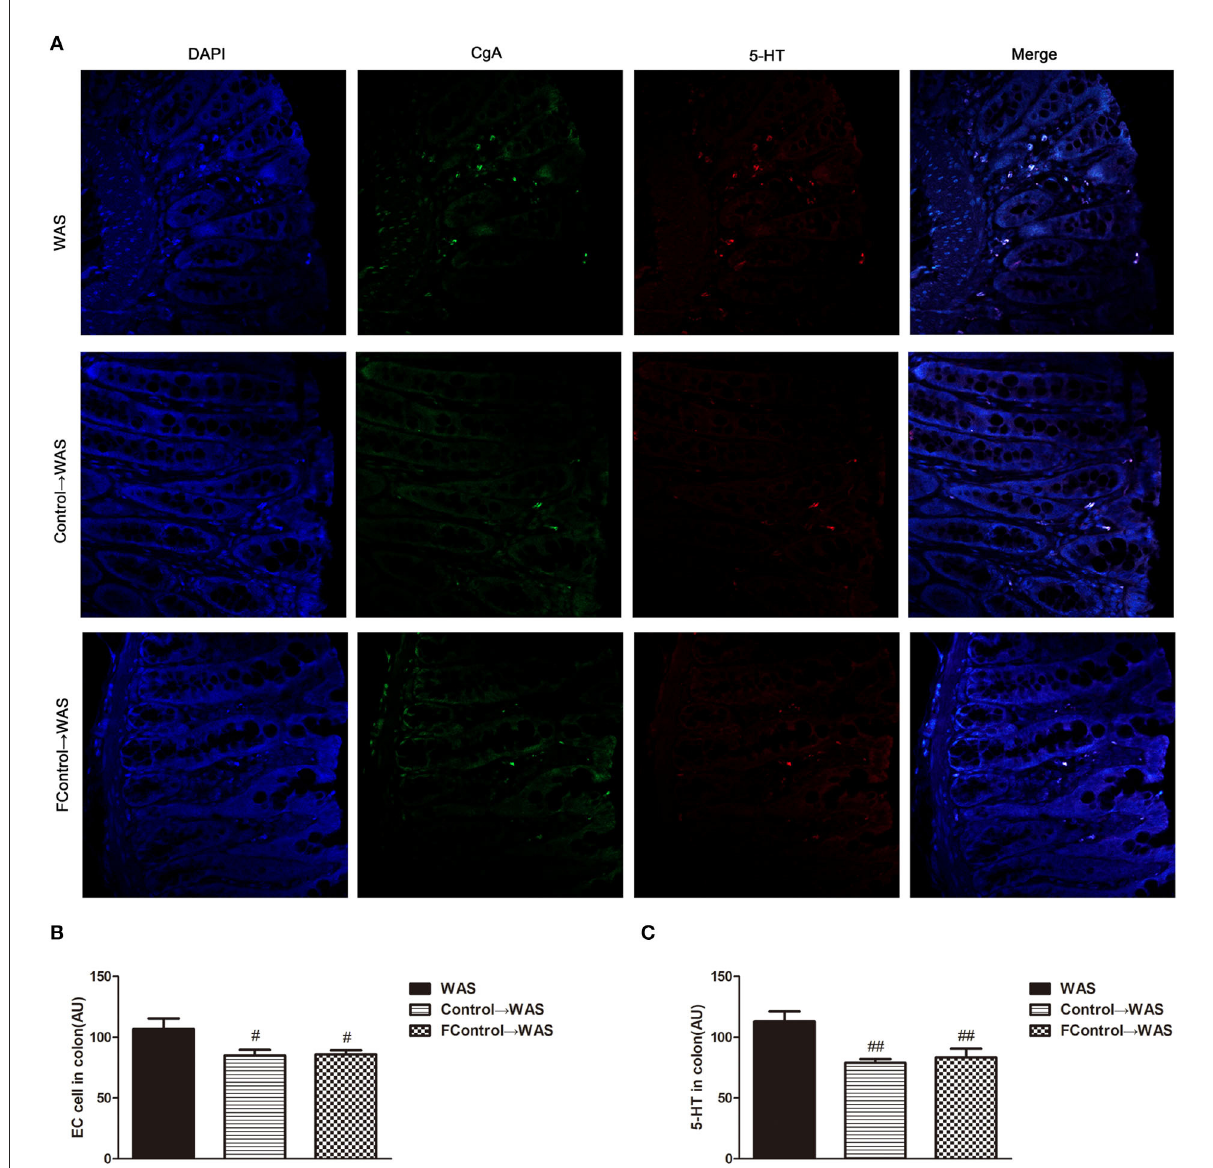
FIGURE7 Effect of filtered FML on ECs numbers and 5-HT Content in the Colon of Rats. (A) Colon immunofluorescence staining in rats. (B ) Statistical plot of ECs numbers in the colon. (C) Statistical plot of the 5-HT content in the colon (All results are expressed as mean ± SE n = 5/group, # P < 0.05 vs. WAS, ## P < 0.01 vs.